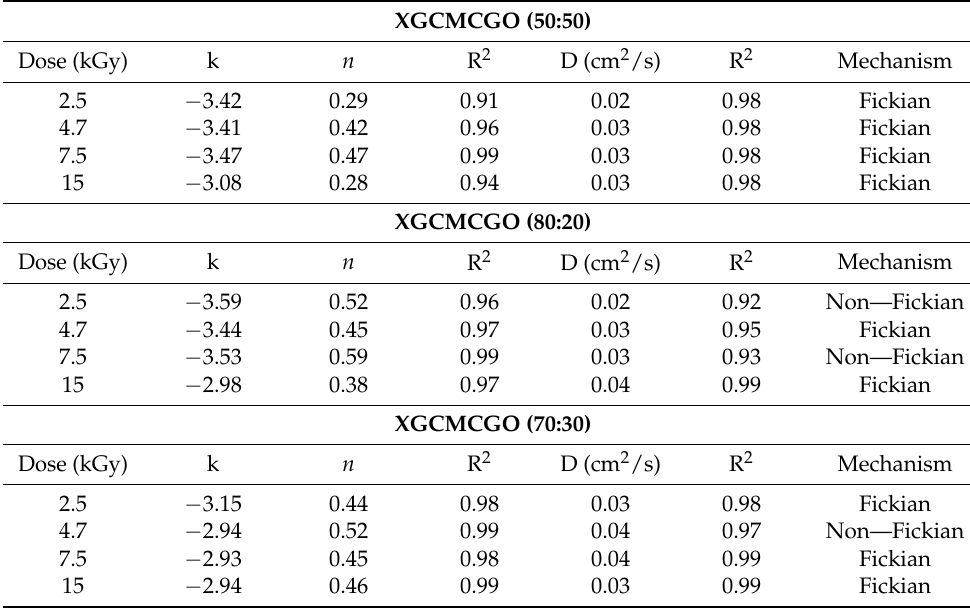
Table 3. Parameters k, n , and D for the XGCMCGO